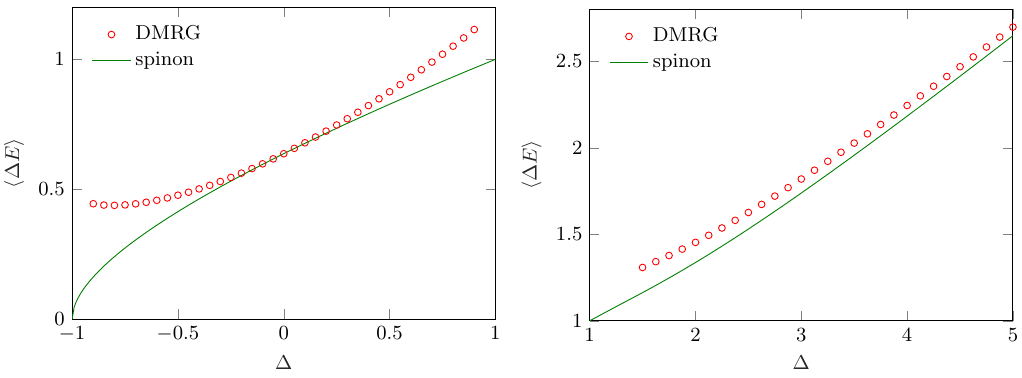
Figure 10: Energy difference due to the insertion of local operator m (left) and ˜ m in the gapped (right) regime. DMRG results (symbols) for L = 400 are 1 compared to the spinon ansatz (lines) in Eq. (71). Note the different vertical